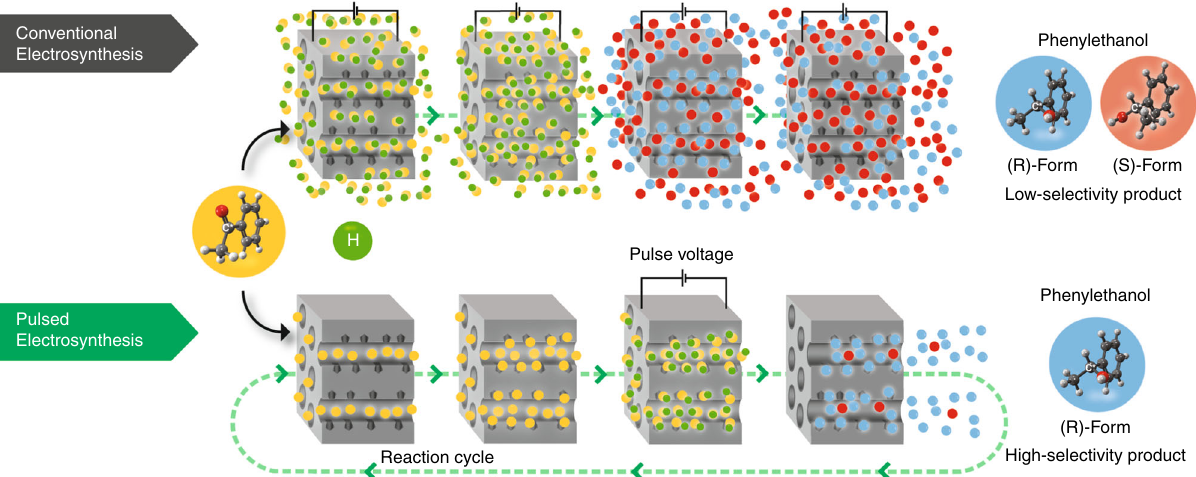
Fig. 1 Comparison of conventional and pulsed chiral electrosynthesis. Illustration of the conversion of achiral acetophenone (yellow dots) into (R) - and (S) -PE (blue and red dots, respectively) by stereoselective addition of hydrogen (green dots) during conventional and pulsed asymmetric electrosynthesis using chiral-encoded metal